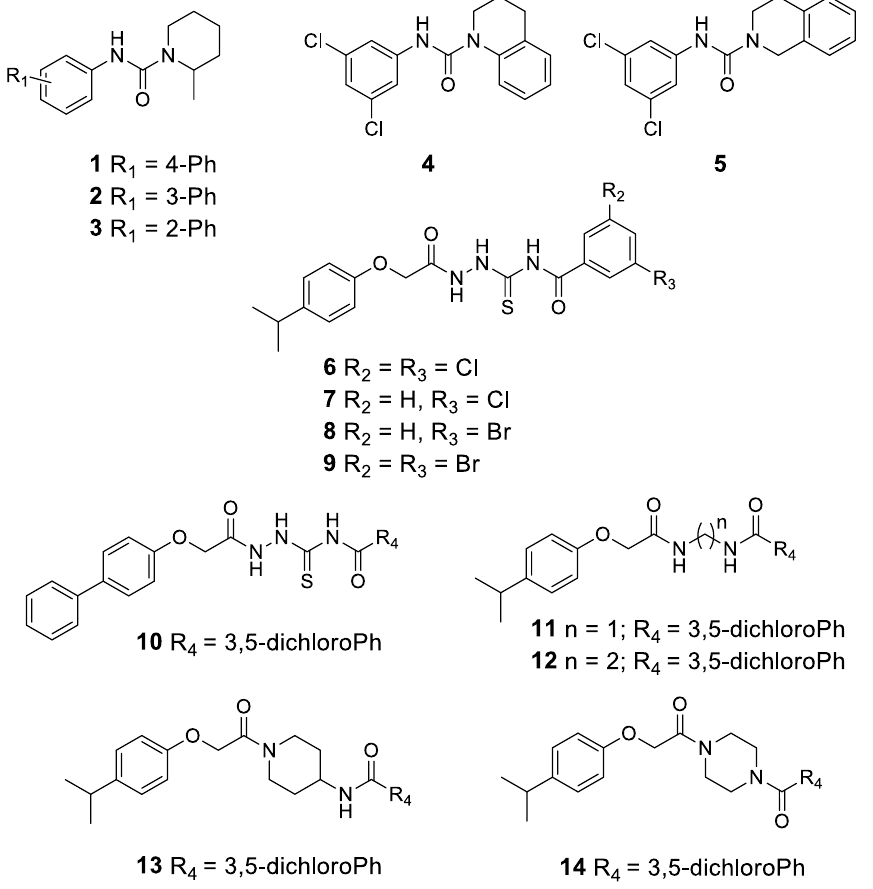
Figure 2. Structures of compounds 1 – 14 , object of the present work.